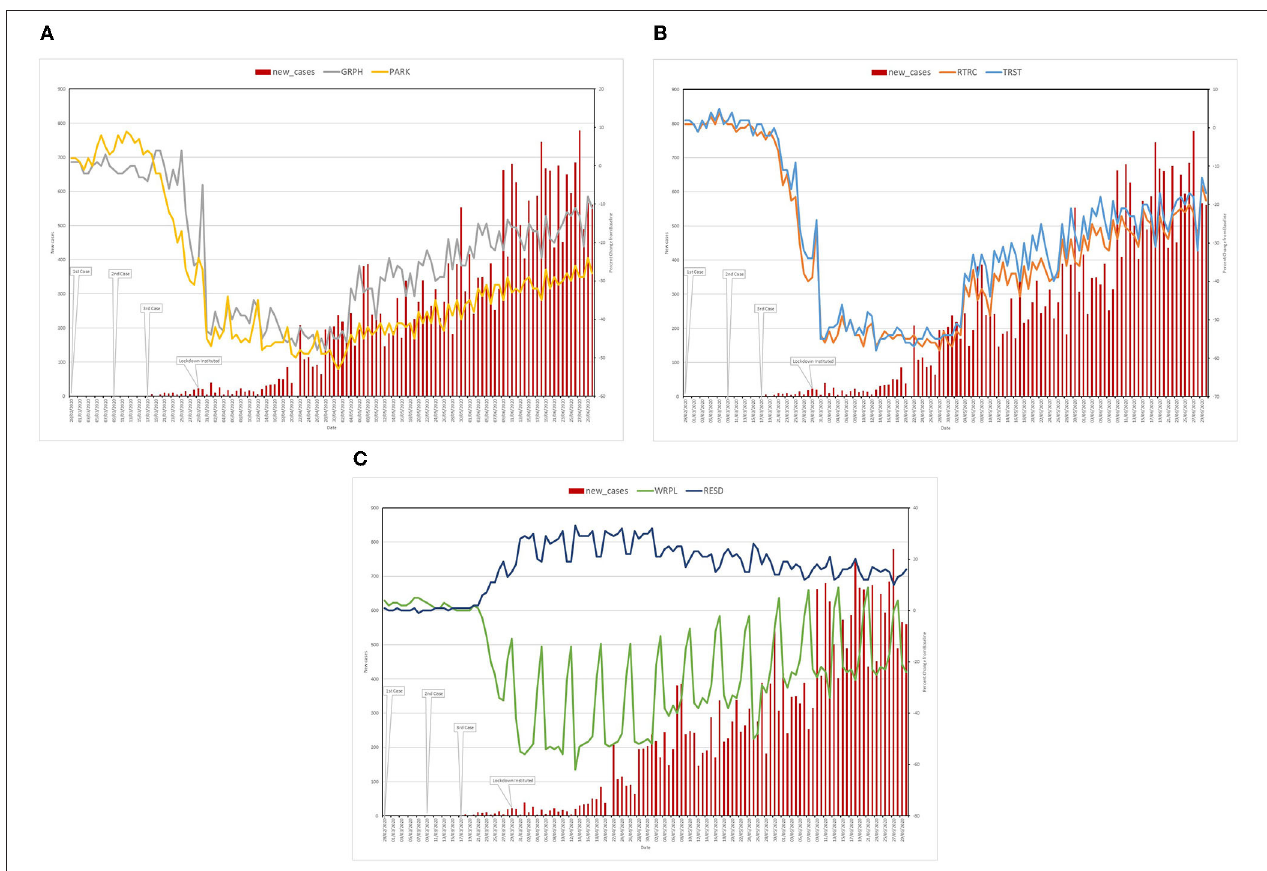
FIGURE 2 | Trend of new cases and percentage changes in mobility from baseline to selected destinations (A) Place categories: WRPL and RESD (B) Place categories: RTRC and TRST, and (C) Place categories: GRPH and PARK.